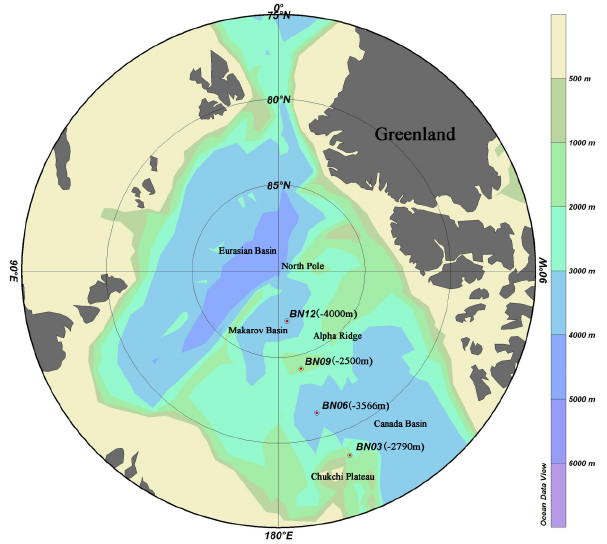
Figure 1. Locations of the deep-sea sediment sampling sites in the high-latitude Arctic